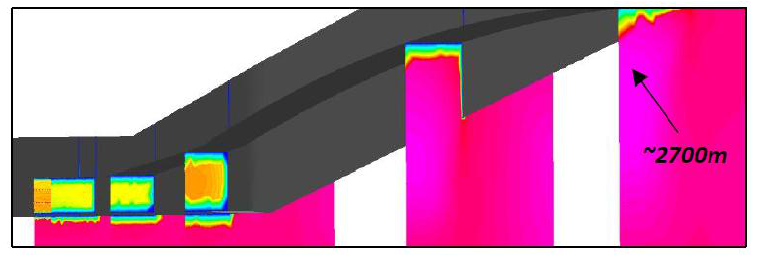
Figure 36. Integrated 3-D scramjet, velocity contour (m/s) planes.